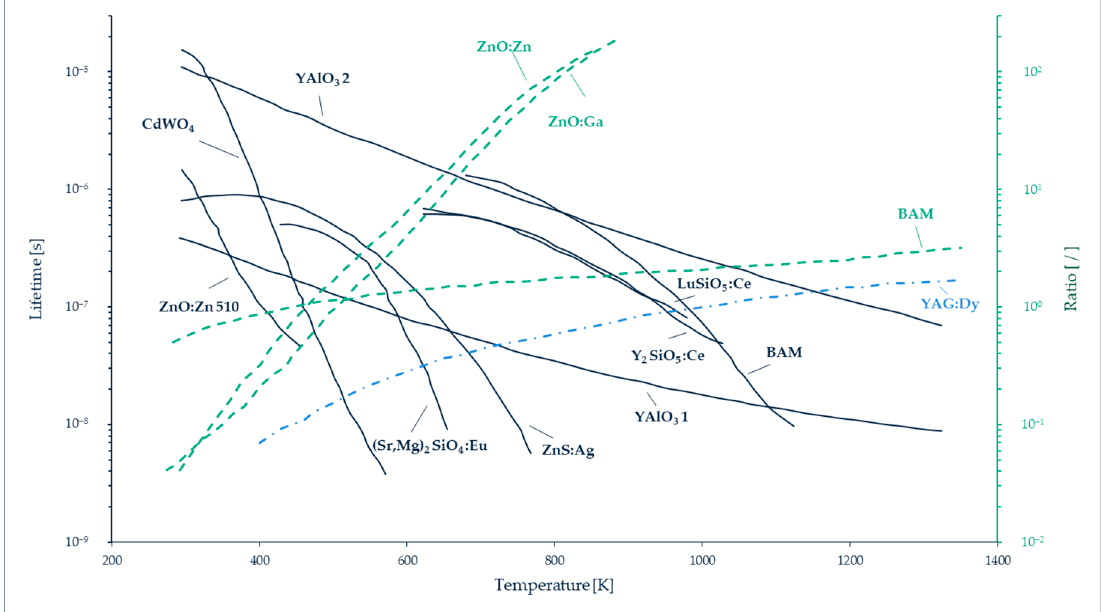
Figure 15. Temperature sensitivity of different types of thermographic phosphors using both two- color and lifetime analysis techniques. Data from Särner et al.